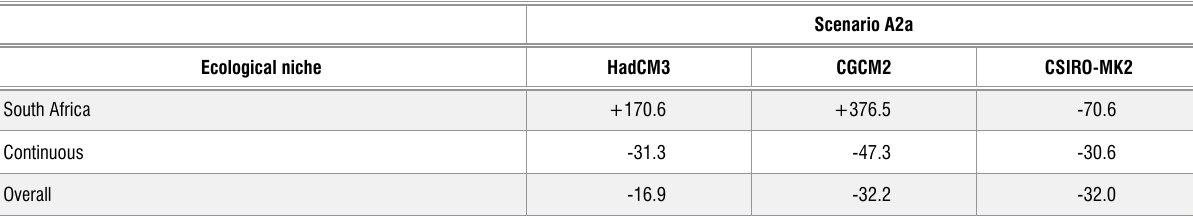
Percentage ecological niche change by 2050 for Brachystegia spiciformis woodland in southern Africa according to three different climatic models under the A2a scenario